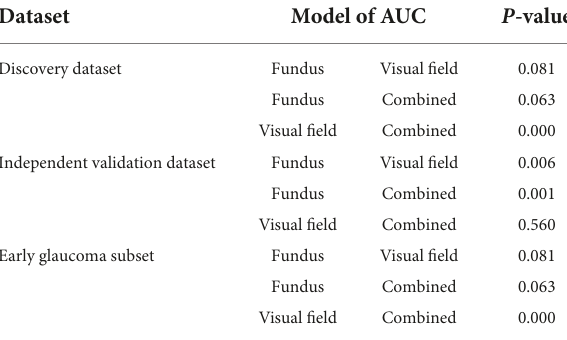
TABLE 3 Pair-wise comparison of the AUCs based on the method of Delong et al. (35). Dataset P -value Discovery